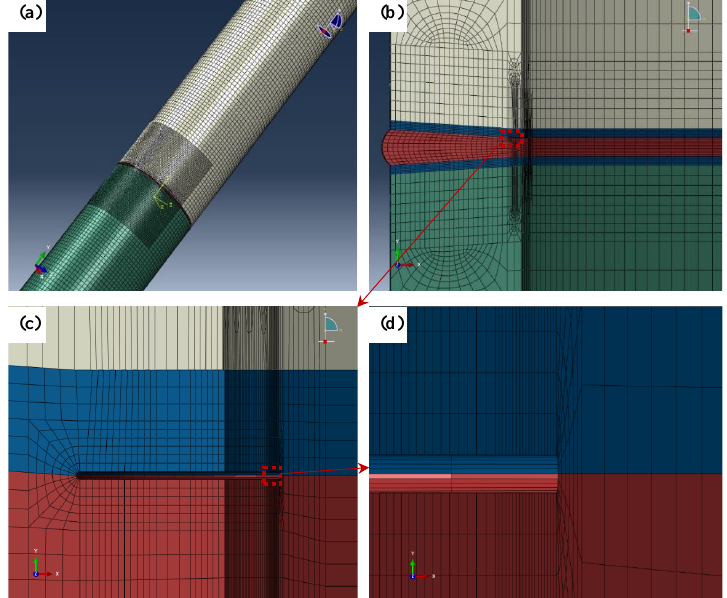
Figure 8. Schematic diagram of FE model for the tube (crack depth is 4 mm). ( a ) The pipe model; ( b ) Mesh of the welding joint; ( c ) Mesh of the area near the crack tip; ( d ) Mesh of the area near the end of the notch.